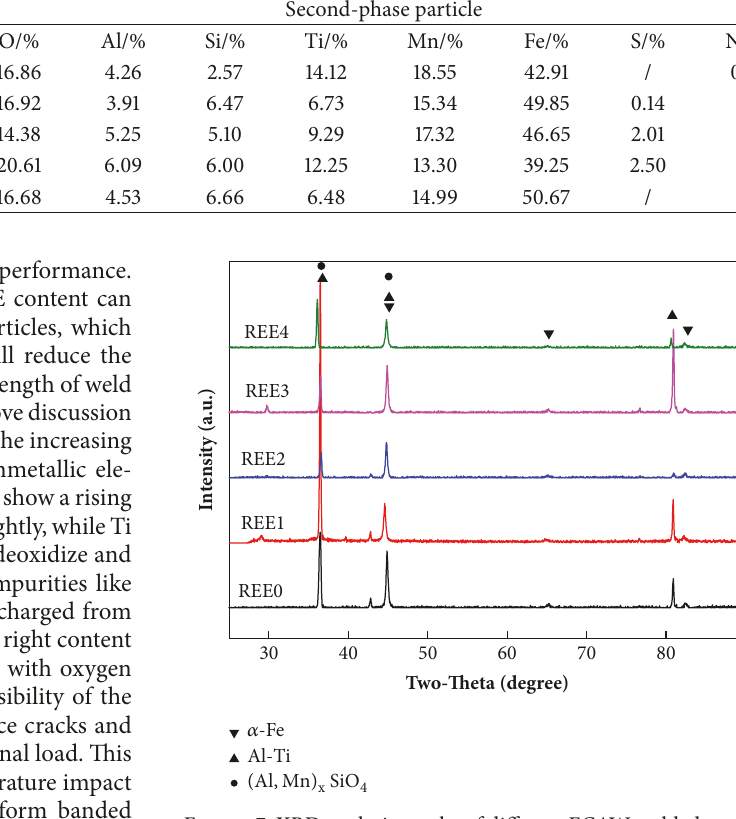
Figure 7: XRD analysis results of different FCAW-welded